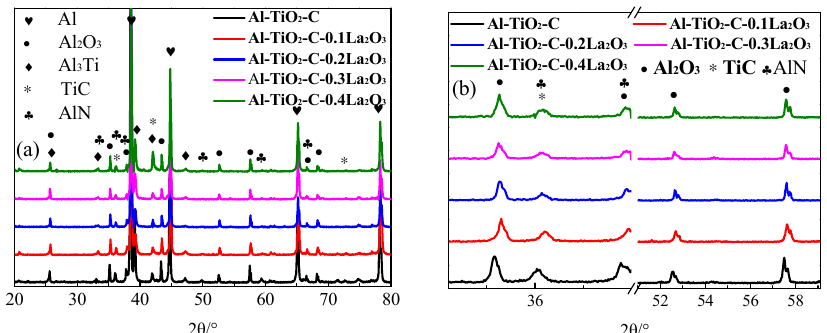
Figure 3. ( a ) XRD (X-ray diffraction) patterns of the Al-TiO 2 -C-XLa 2 O 3 refiners; ( b ) 33–59°.